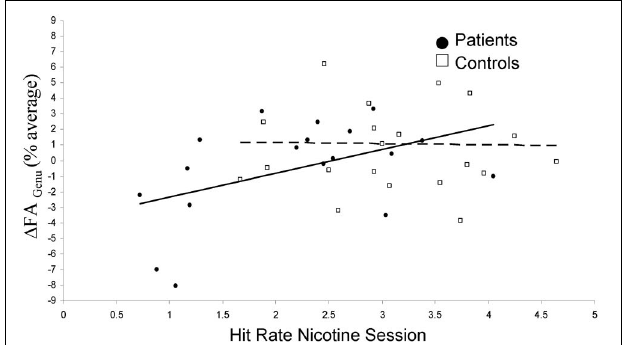
FIGURE 4 | Nicotine-related changes in FA values of the genu of corpus callosum ( (cid:2) FA Genu ) are plotted against the hit rate during nicotine session, separately in schizophrenia patients (solid point/line) and normal controls (hollow points/dashed line).